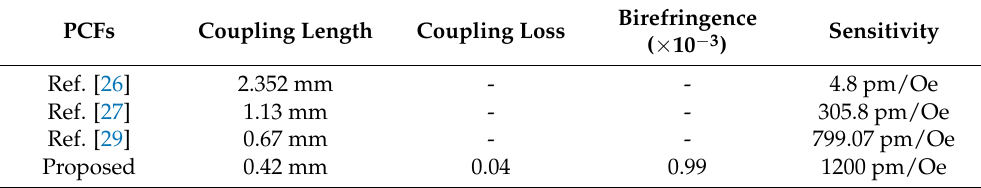
Table 1. Comparisons of essential properties of previous PCFs with the suggested PCF.